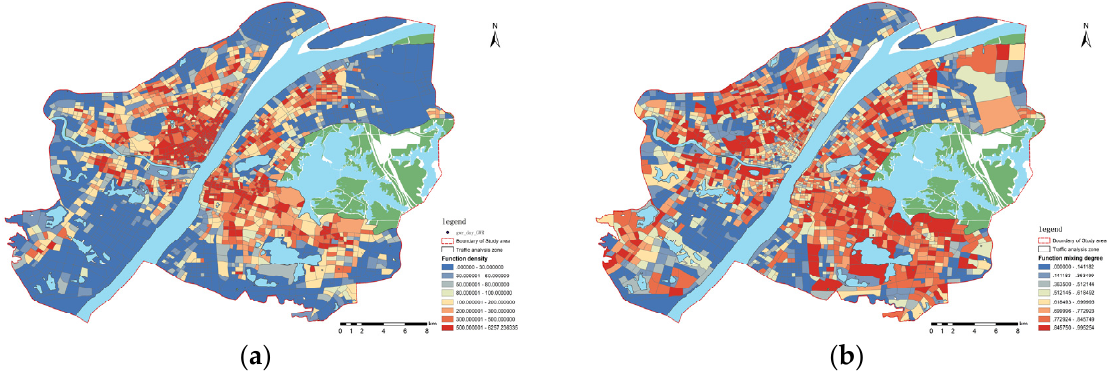
Figure 11. Block function. ( a ) Block function density; ( b ) block-function-mixing degree.